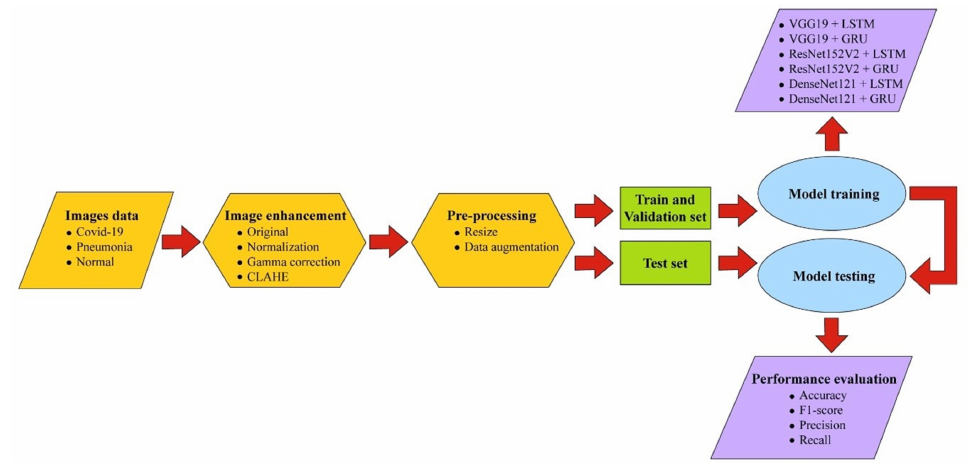
Figure 1. Block diagram of our